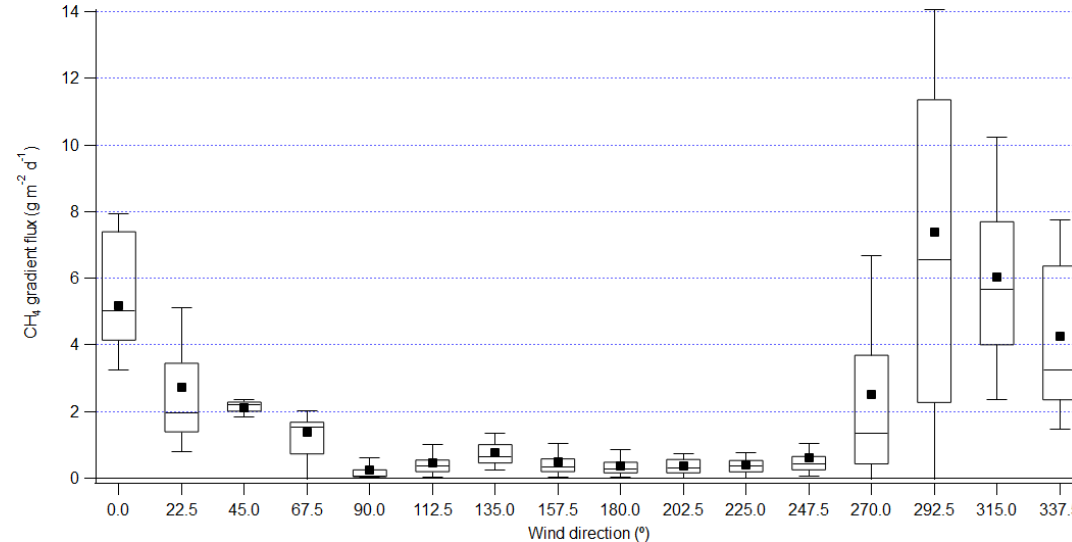
Figure 2. Gradient flux of CH 4 from FTIR binned by wind direction in 22.5 ◦ bins. Lower and upper bounds of the box plot are the 25th and 75th percentile; the line in the box marks the median and the black square labels the mean; the whiskers label the 10th and 90th